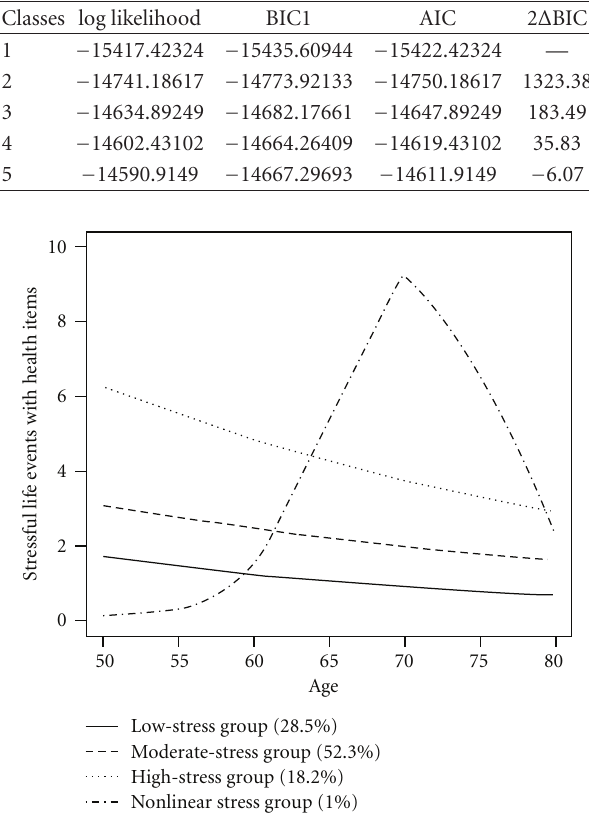
Figure 2: Graphs of the predicted trajectories for the di ff erent stressful life event classes (including health